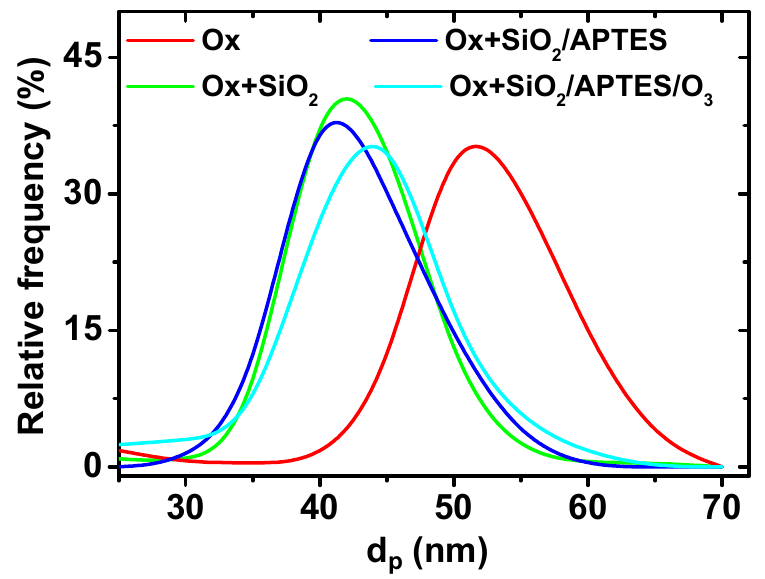
Figure 3. Pore diameter distribution obtained by image analysis of nanoporous alumina membranes before (Ox) and after SiO 2 (Ox+SiO 2 ), SiO 2 /APTES (OX+ SiO 2 /APTES) and SiO 2 (OX+ SiO 2 )/APTES/O 3 ALD deposition.